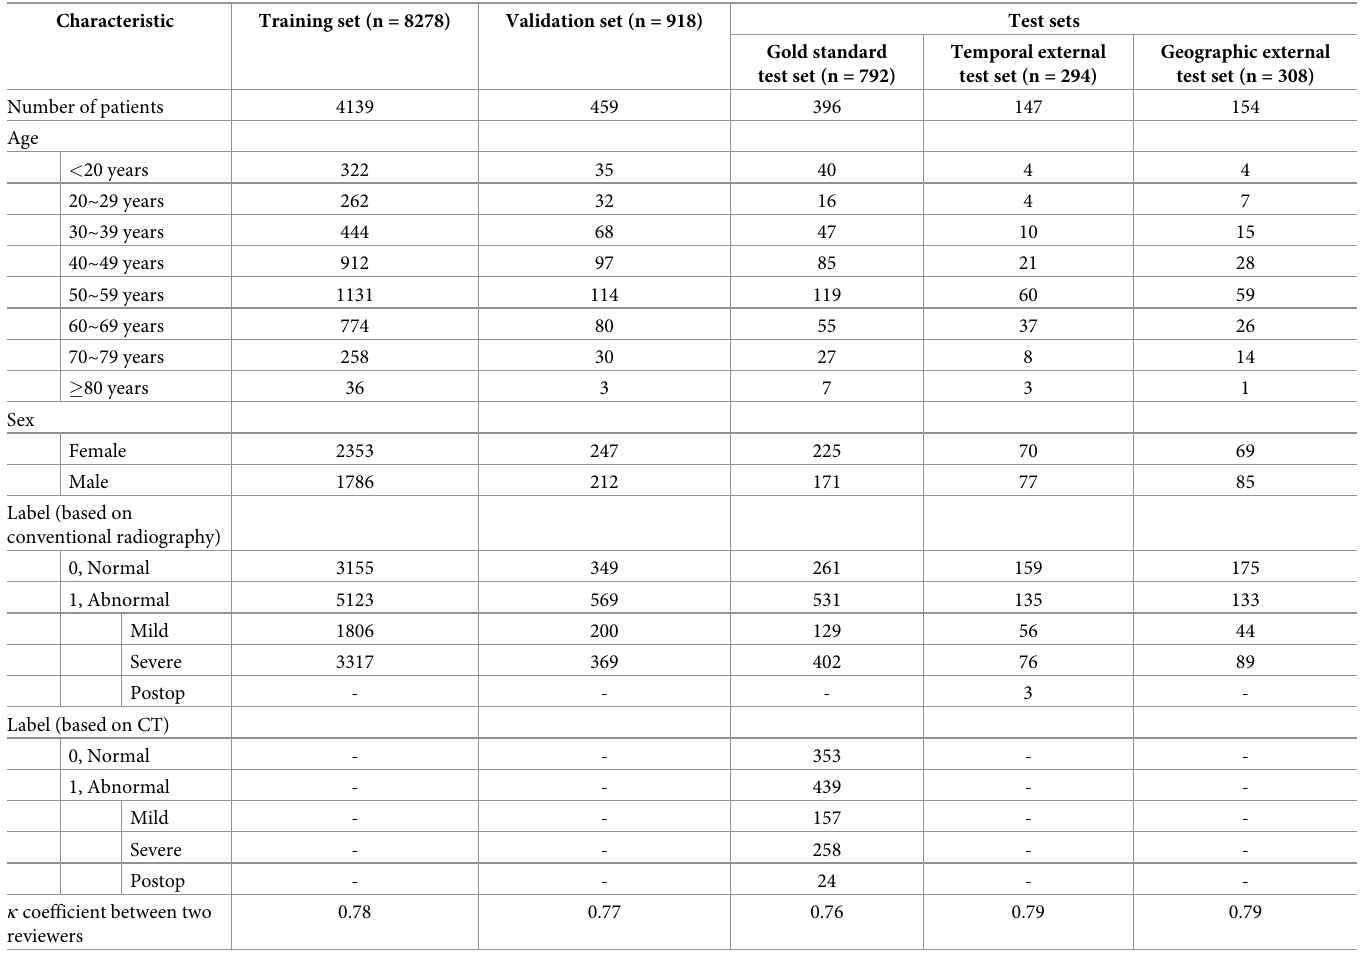
Table 1. Baseline characteristics of all data